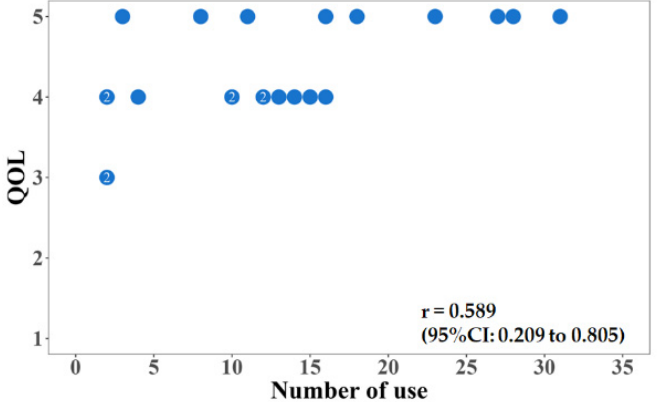
Figure 4. Relationship between number of times the Choisoko using and QOL.